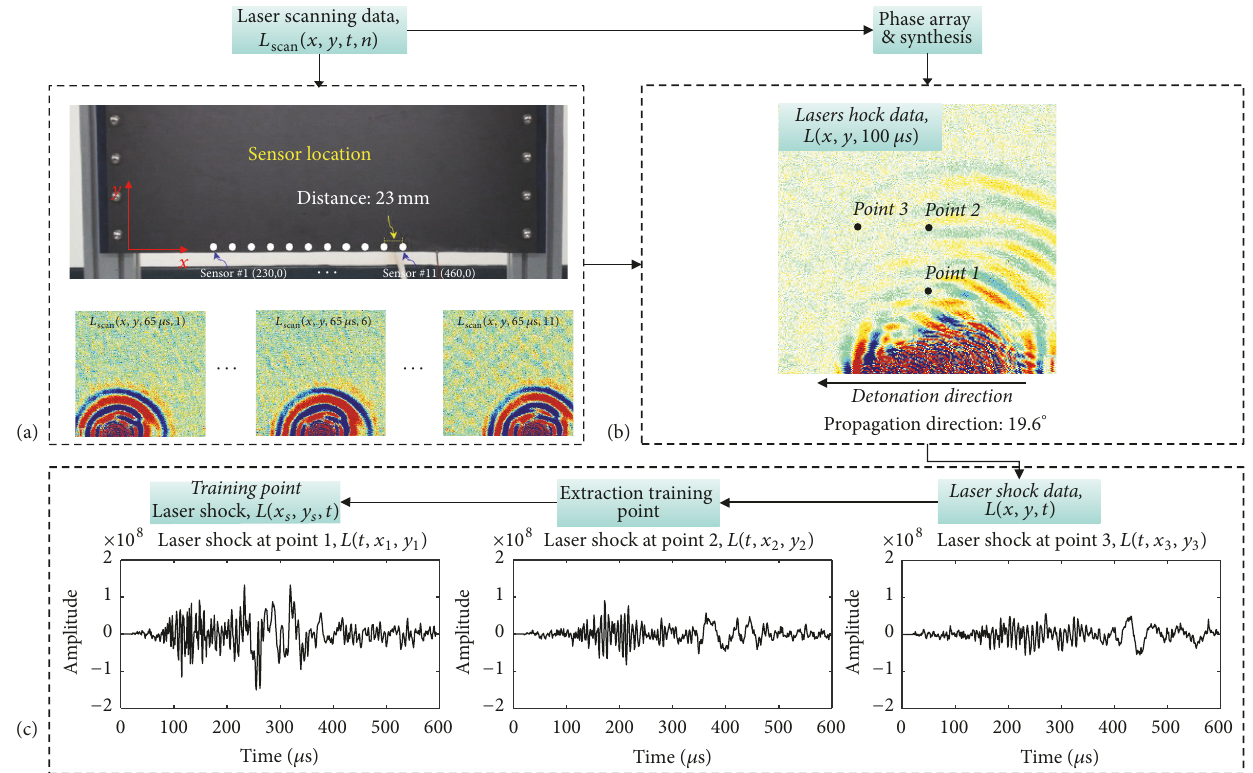
Figure 11: (a) Snapshots of laser scanning data at 65 𝜇 s obtained by each sensor. (b) Snapshot of synthesized laser scanning data at 100 𝜇 s. (c) Training point laser shock, 𝐿(𝑥 𝑠 , 𝑦 𝑠 , 𝑡)